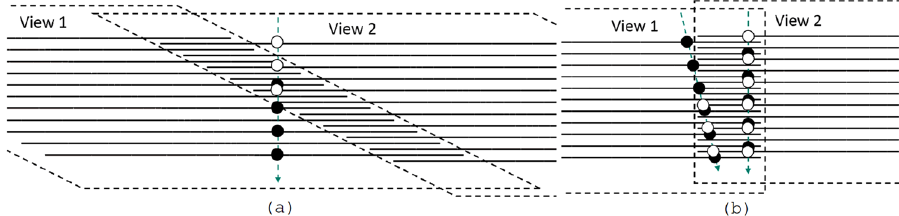
Figure 5. Tracks crossing adjacent views, made of grains in tilted ( a ) and vertical ( b ) overlapping piles of images. Dashed arrows represent particle tracks. Solid horizontal lines represent images. Circles represent images of grains detected along the track. Black (white) circles are clusters detected in the left (right)